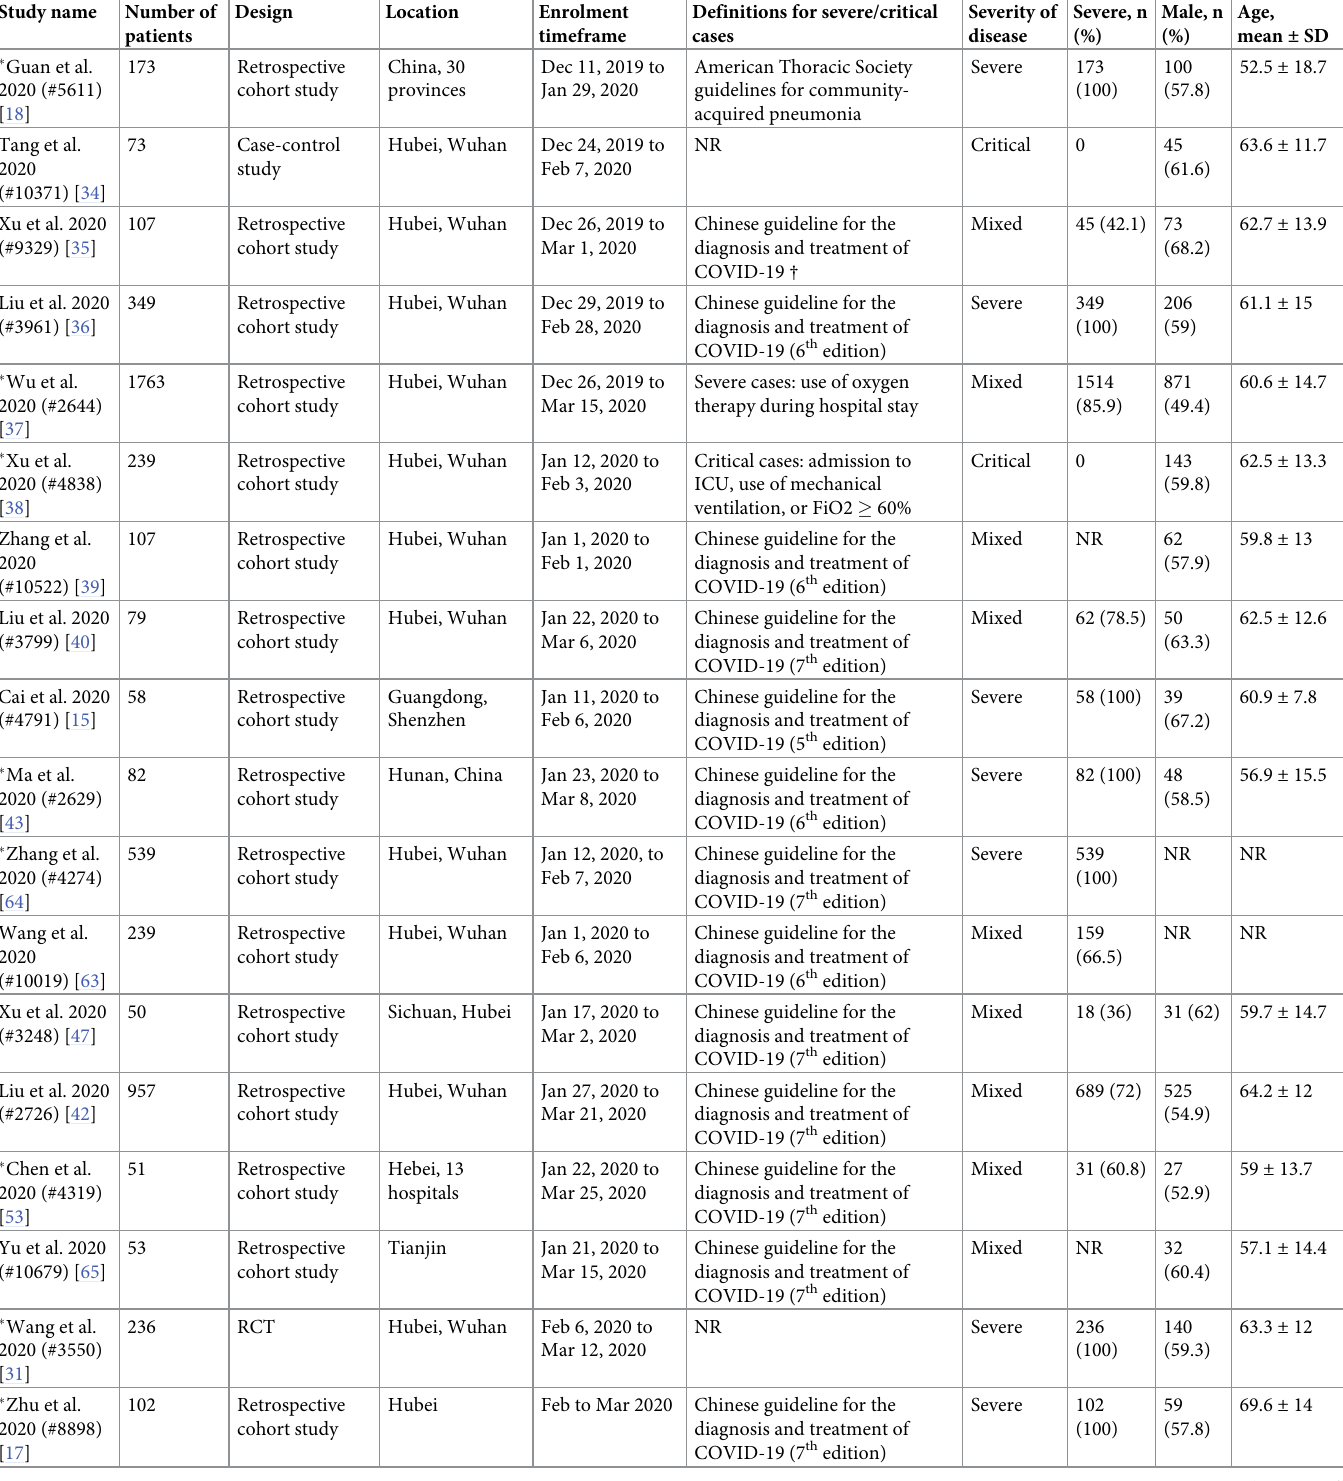
Table 1. Characteristics of studies included in the meta-analysis in patients with severe or critical COVID-19 (n =